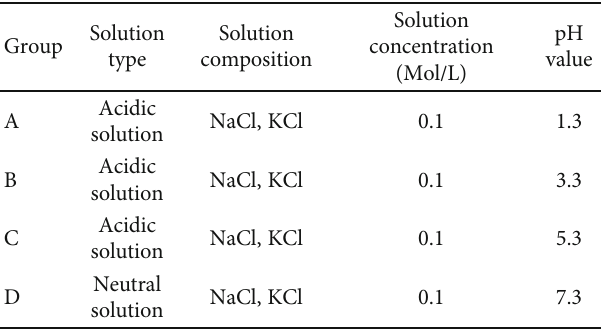
Table 1: Preparation of chemical